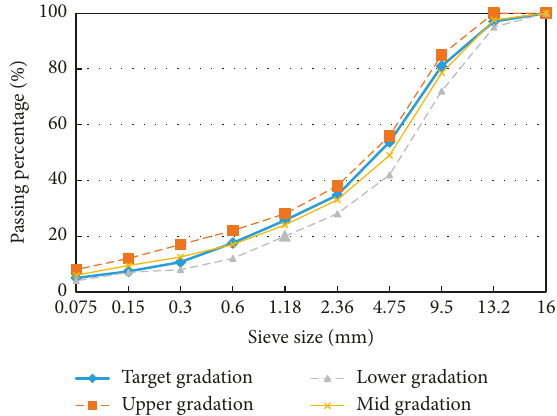
Figure 4: Gradation curve of asphalt mixtures of AC-13.